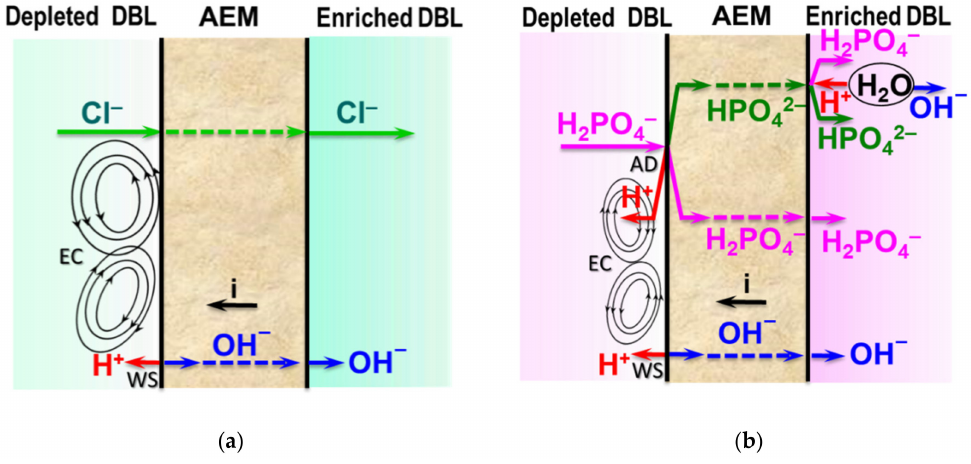
Figure 18. Scheme of proton and hydroxyl ions generation in the system AEM/NaCl ( a ) and AEM/NaH 2 PO 4 ( b ) solution. WS: water splitting; AD: the acid dissociation mechanisms, EC: